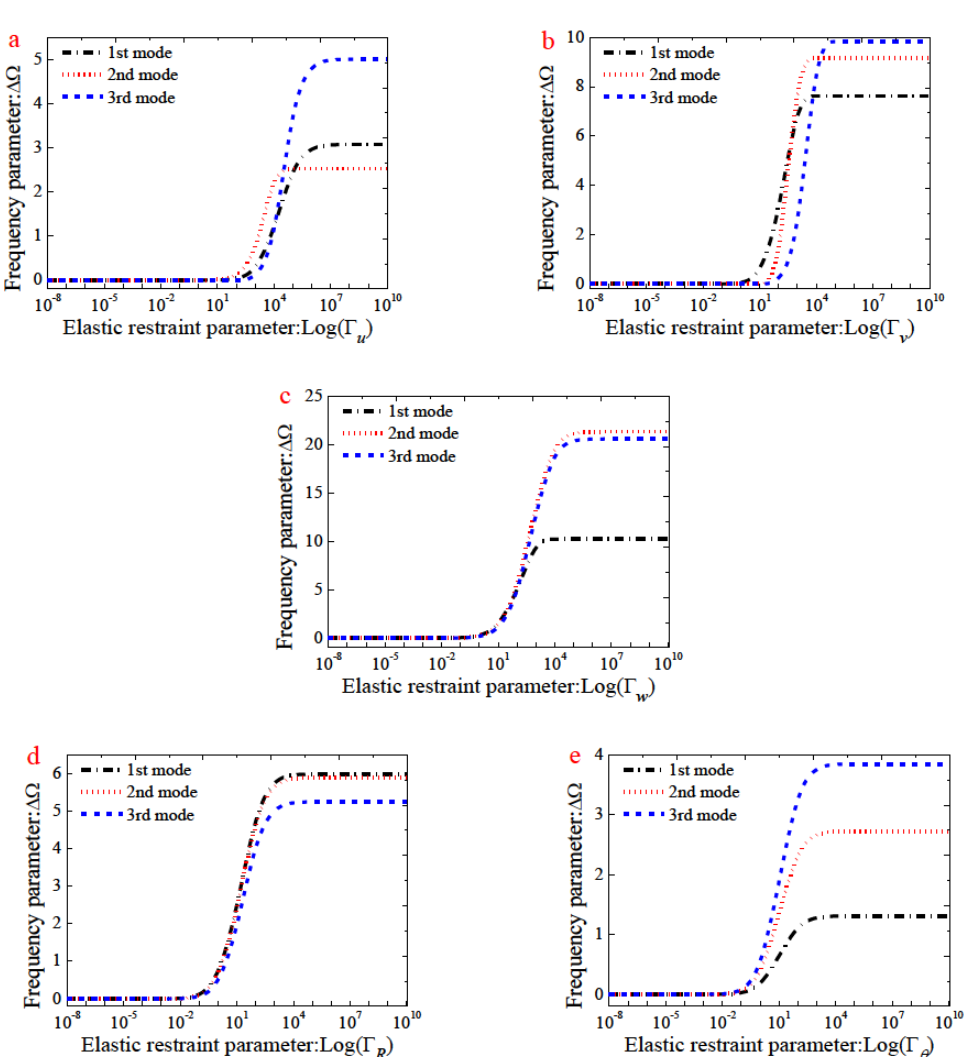
Figure 3: Variation of the frequency parameters ∆Ω versus the elastic restraint parameters Γ λ for a three-layered, [0 o /90 ∘ /0 ∘ ], symmetri- cally laminated annular sector plate: (a) Γ u ; (b) Γ v ; (c) Γ w ; (d) Γ R ; and (e) Γ